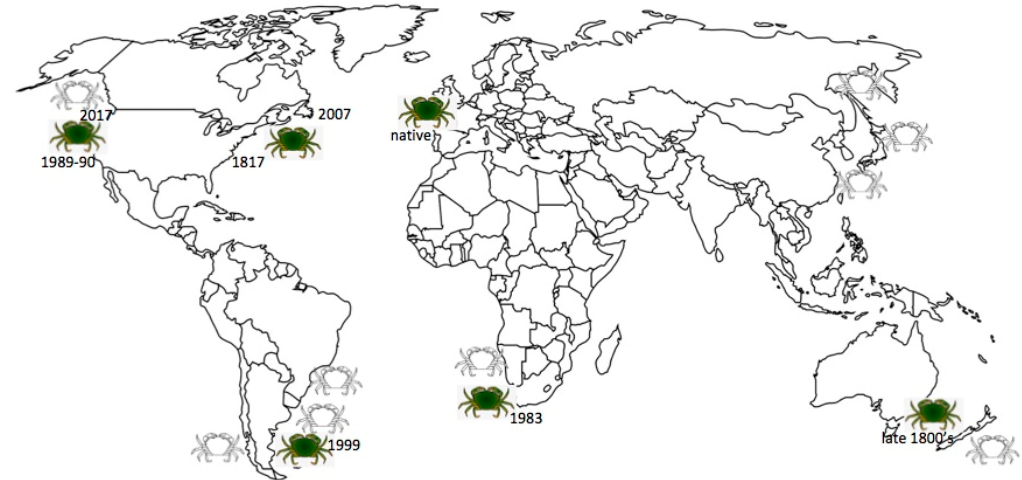
Figure 1. Worldwide distribution of green crab ( Carcinus maenas ) populations as of 2019. Solid icons represent established populations with dates of introduction. Open icons indicate potential locations for future invasions.